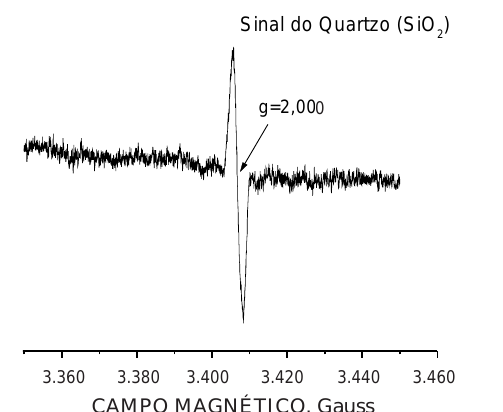
Figura 2. Espectro de EPR de uma amostra pura de quartzo (SiO